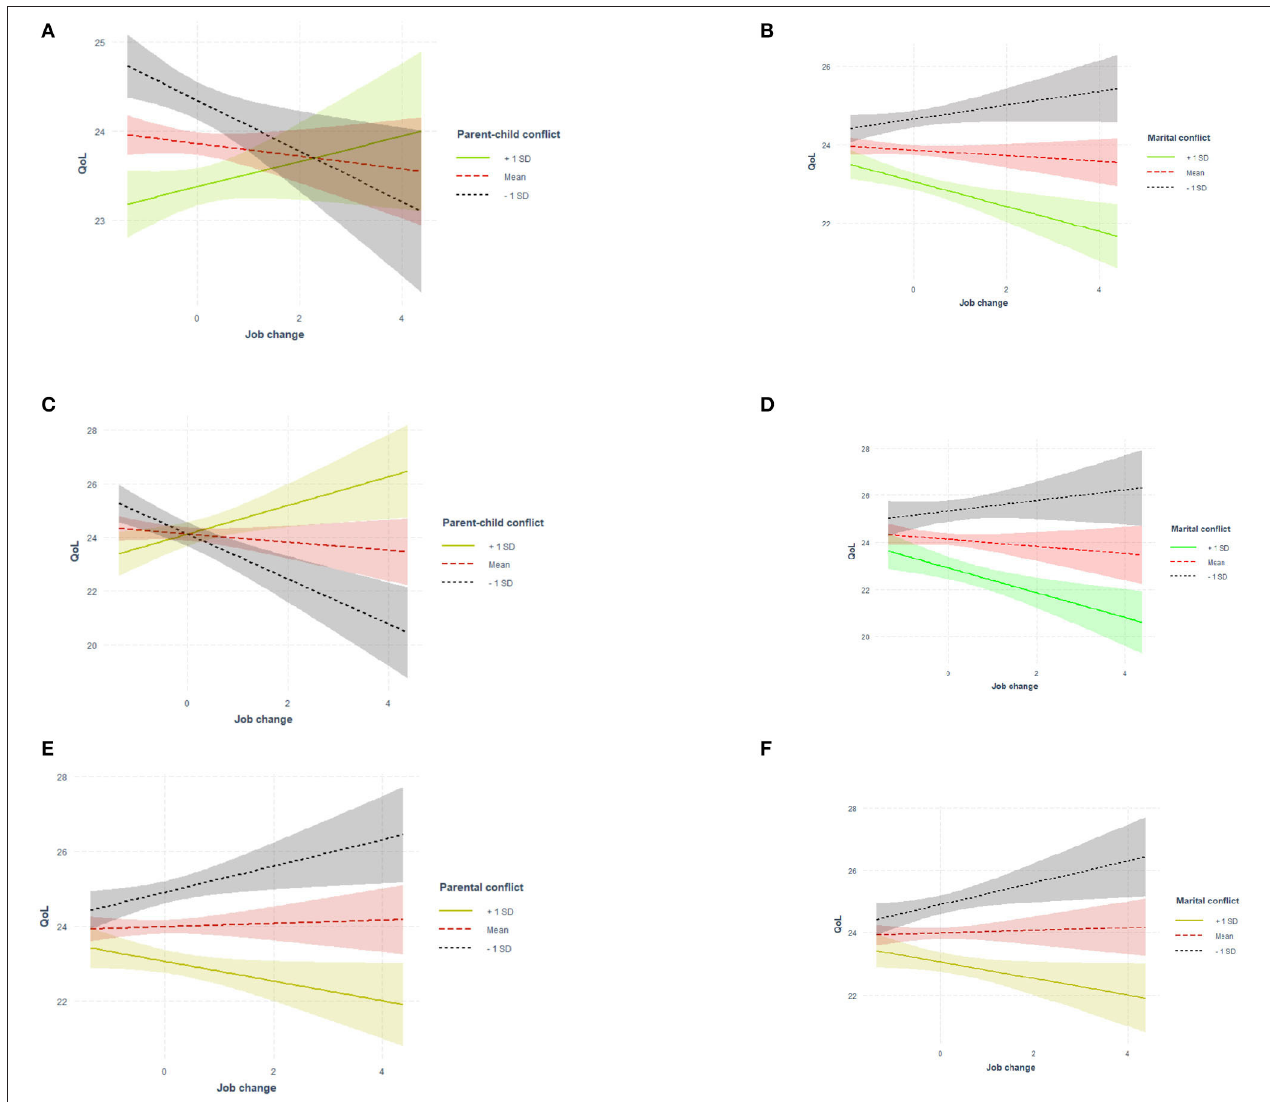
FIGURE 1 | Interaction effect of job change and family conflict. (A,B) Whole sample. (C,D) Male sample. (E,F) One child